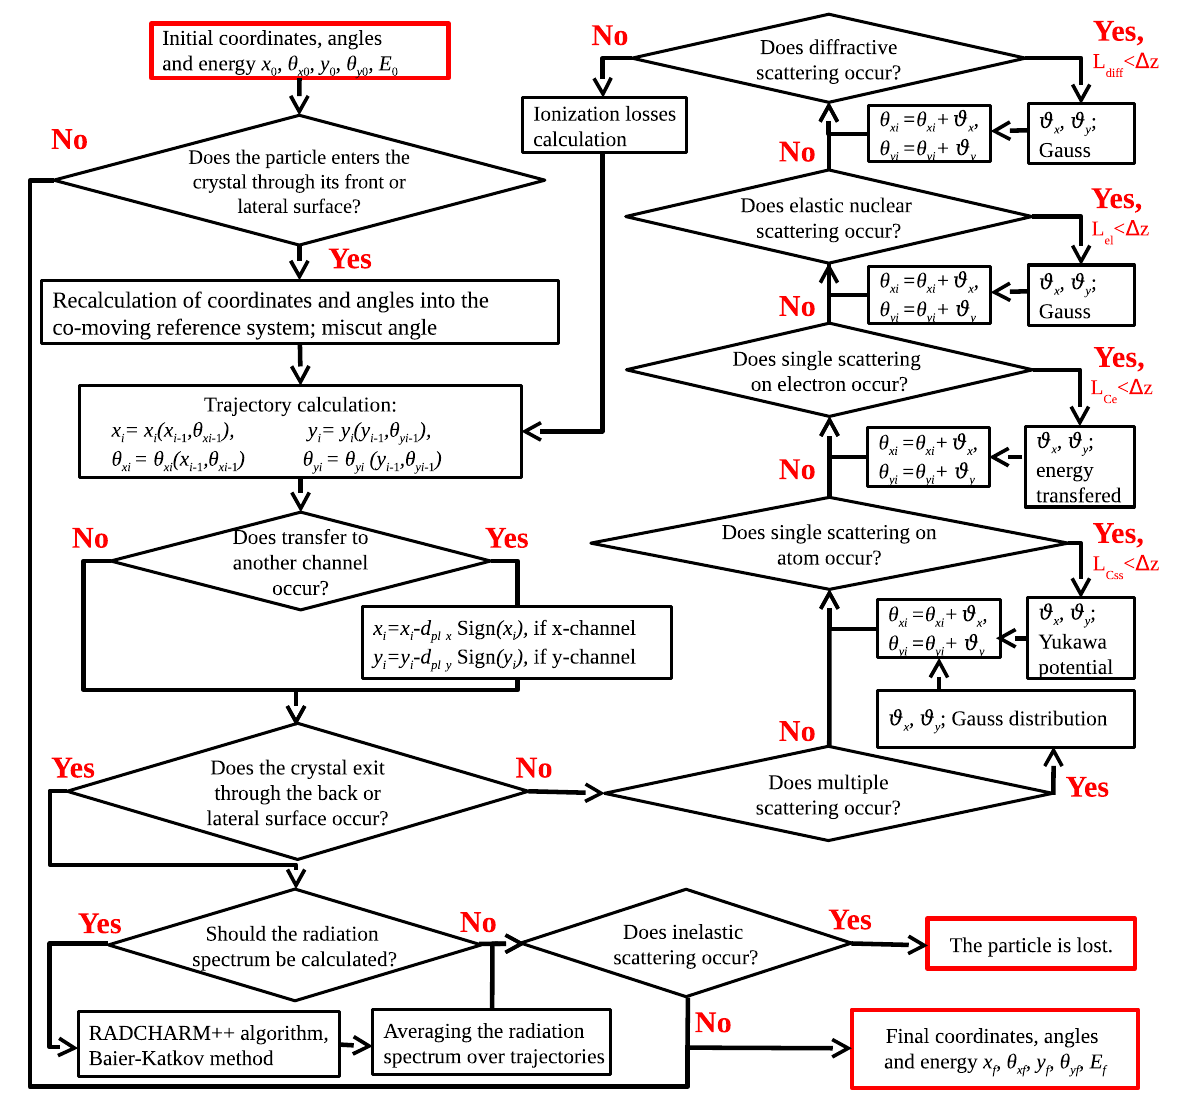
FIG. 3. The algorithm of CRYSTALRAD simulation